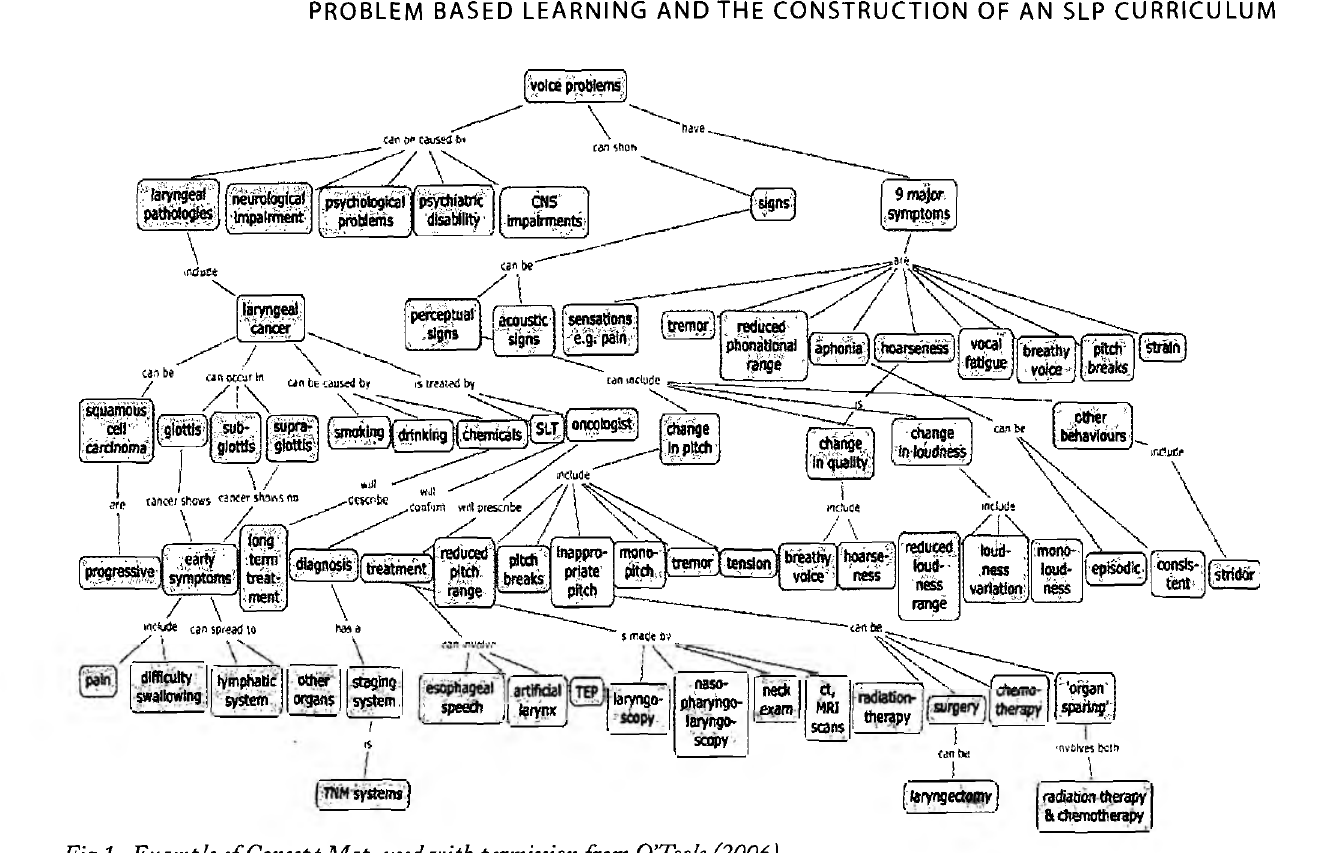
Fig 1. Example of Concept Map, used with permission from O’Toole (2006). impact on the success of PBL outcomes in learners (Caplow, Donaldson, Kardash, 8c Hosokawa, 1997). The skills